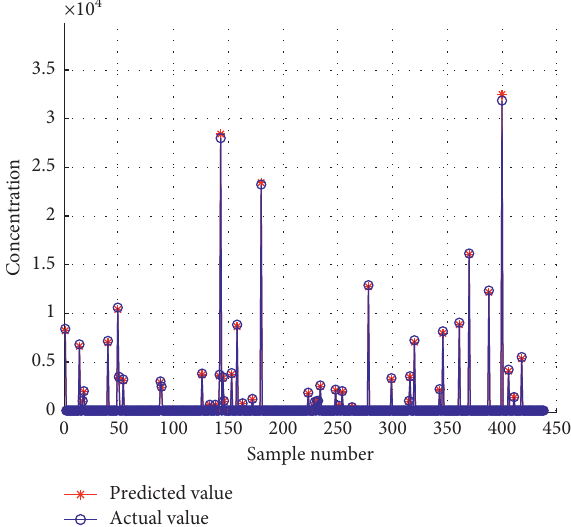
Figure 17: The Jinan test set data prediction effect diagram.